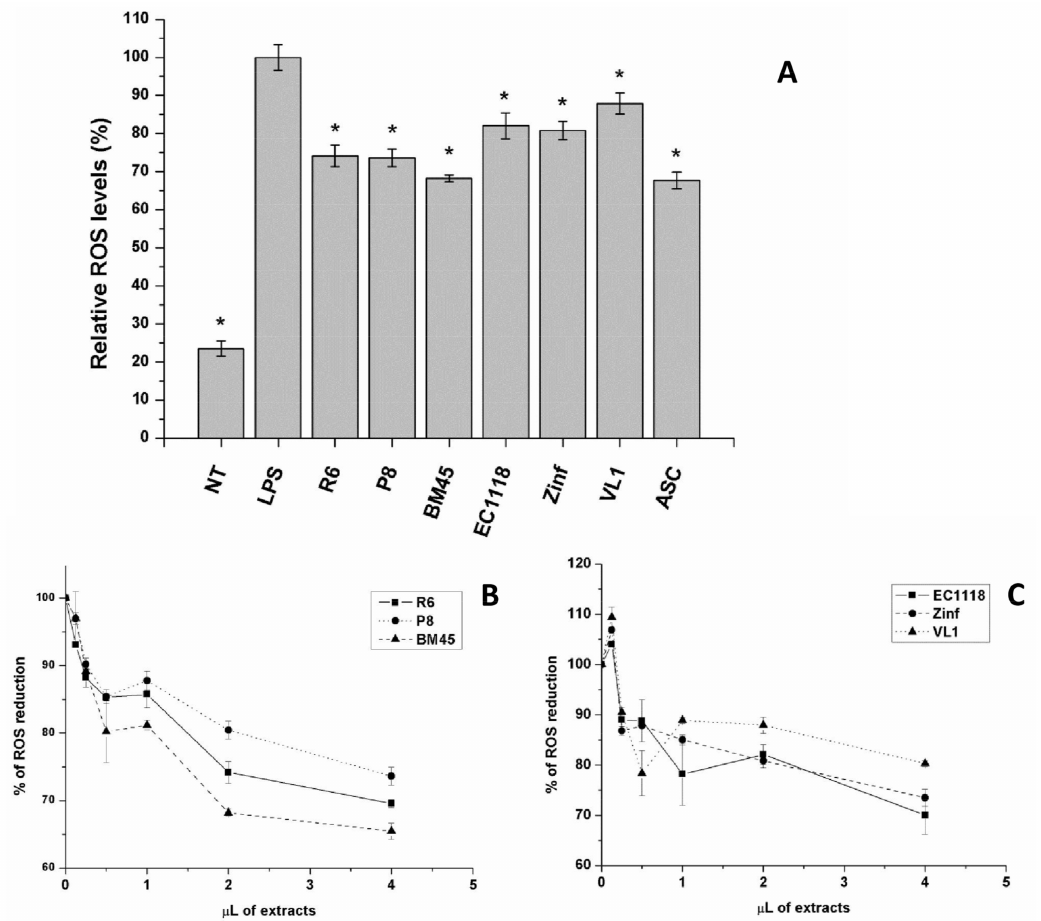
Figure 3. Effect of samples obtained from experimental wines on intracellular ROS level. ( A ) ROS were determined in RAW 264.7 cells pre-treated with samples (2 µ L) and stimulated with LPS (1 µ g/mL). A positive control was obtained by treating cells with LPS. Values from non-treated cells (NT) were used as a negative control. ASC represents cells pre-treated with 0.05 mM. Results are expressed as % ROS content taking the value of the positive control as 100 and they are the mean of three different experiments performed in duplicate. Bars indicate S.D. (* p < 0.01 vs. positive control) ( B , C ) dose-response relation of samples. 0.25–4.0 µ L of each sample was used to treat cells, and ROS levels were determined as in